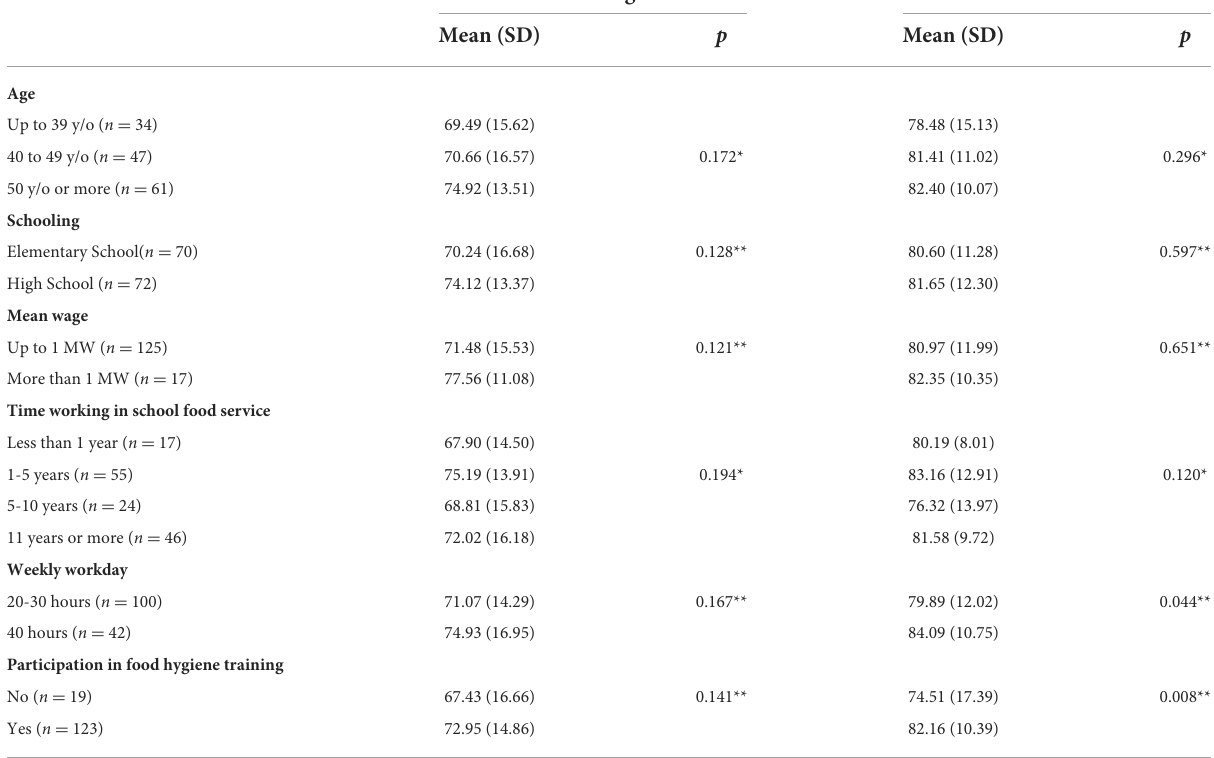
TABLE 3 Mean and standard deviation of attitude and knowledge scores on Good Hygiene Practices of food handlers in School Food Services with different socioeconomic and demographic characteristics. Knowledge